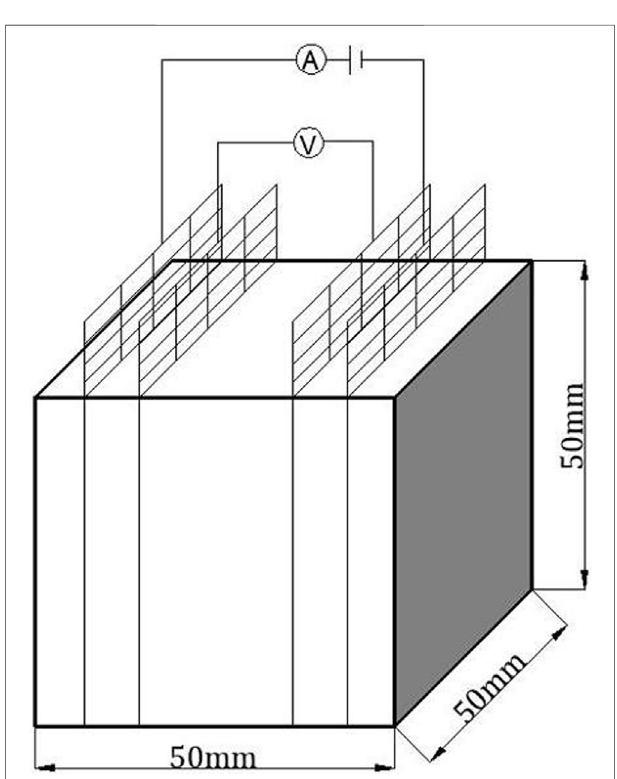
FIGURE1 | Schematic diagram ofelectricalresistance measurement by four-probe method.